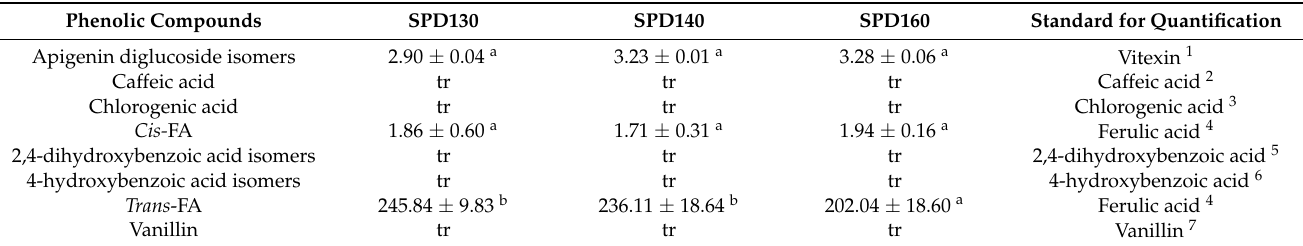
Data are mean values ± standard deviation of two replicates. Different letters in the same row indicate significant differences among mean values of different treatments (one-way ANOVA, post hoc Duncan’s test, p ≤ 0.05). Abbreviations: ferulic acid (FA); traces (tr); hydrolyzed WB spray-dried at 130 ◦ C (SPD130), at 140 ◦ C (SPD140), and at 160 ◦ C (SPD160). 1 Linearity range 0–25 µ g mL − 1 , R 2 =